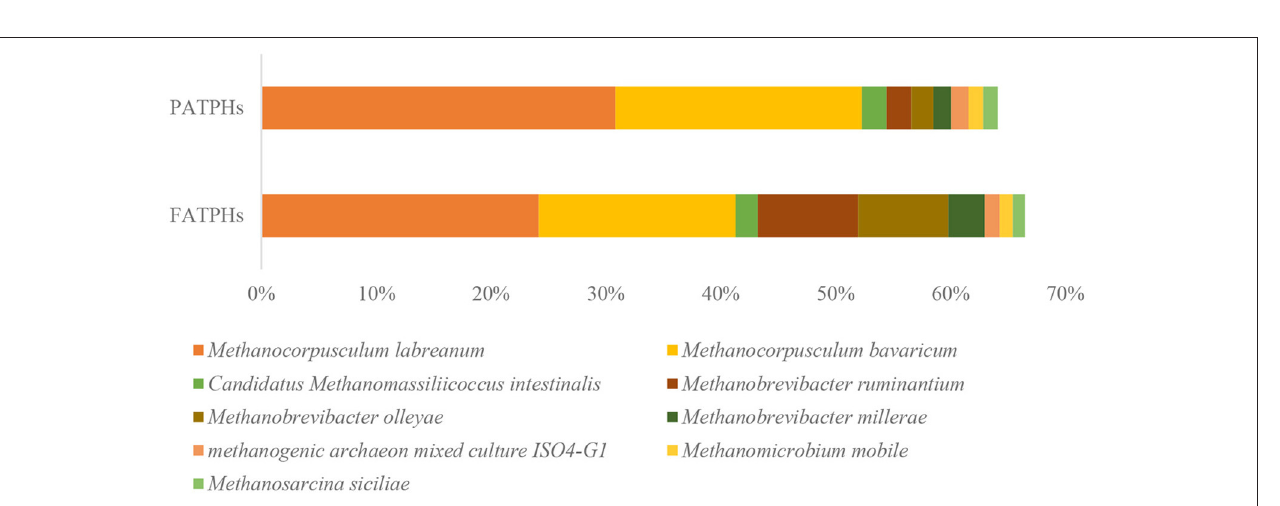
FIGURE 2 | Relative abundances of archaea species ranked by one and zero orders of magnitude in PATPHs shown together with relative abundances of the corresponding species in